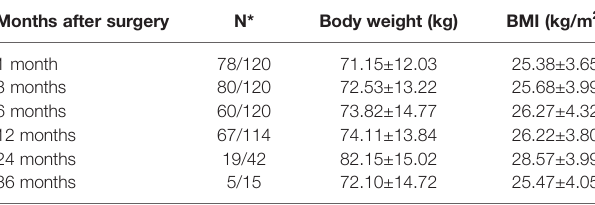
TABLE 4 | Body weight and BMI at each follow-up.